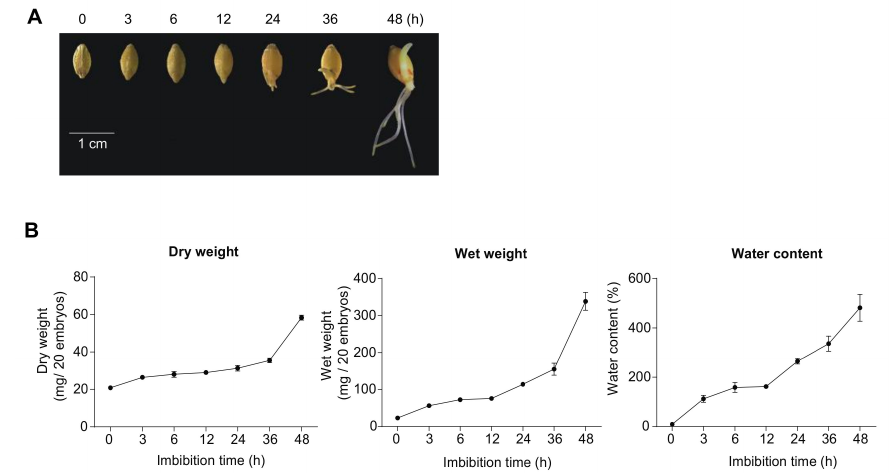
Figure 1. Barley grain germination. ( A ) Developmental stage of barley embryos that were analyzed. Barley embryos were manually dissected from dry (0 h) or imbibed (3 to 48 h) seeds to determine dry and wet weight, to isolate mitochondria and RNA, and for use in oxygen consumption measurements. ( B ) To determine the water content, we dissected embryos from barley grain 0 to 48 h after imbibition. Wet and dry weights were measured for barley embryos and the water content was calculated from these data. For each time point, the mean standard error is shown ( n = 50). Both wet and dry weight increased steadily over time up until 36 h, when the radicle had emerged and thus germination had occurred. A larger increase in both wet and dry weight was observed after 36 h. Water content initially increased up until 6 h, plateaued, and continued steadily after 12